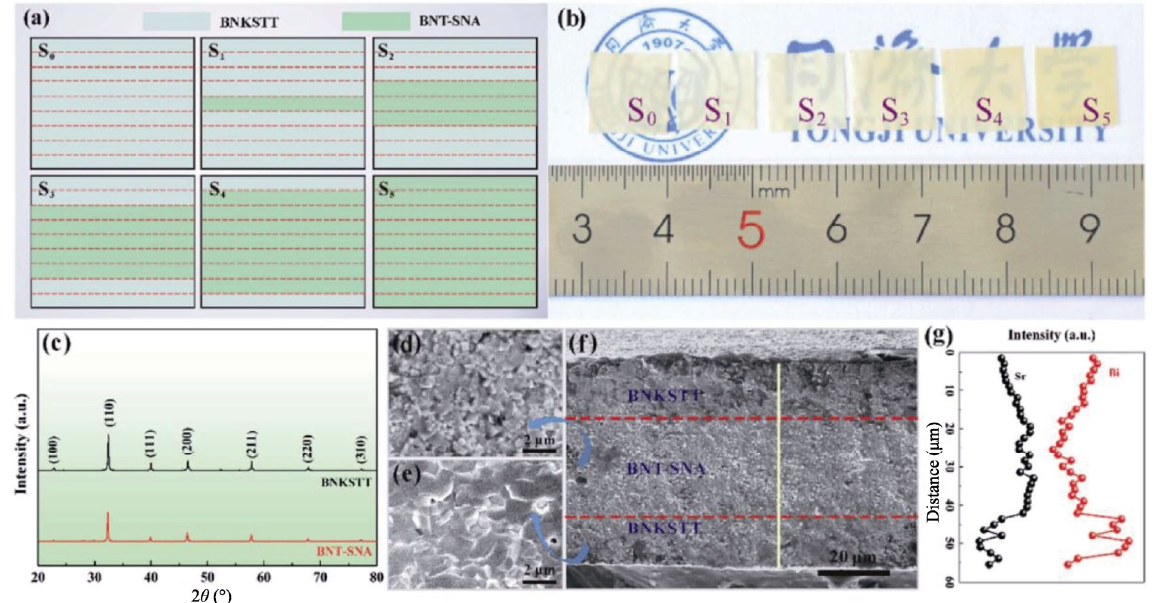
Fig. 22 (a) Schematic diagram of the prepared lead-free ceramics with sandwich structures; (b) photograph of the prepared ceramic samples; (c) XRD patterns for the samples BNKSTT (S0) and BNT-SNA (S5); cross-section images of the BNKSTT layer, the BNT-SNA layer, and S3 are presented in (d), (e), and (f), respectively; and (g) line scanning of the Bi and Sr elements for S3 in (f). Reproduced with permission from Ref. [116], © The Royal Society of Chemistry